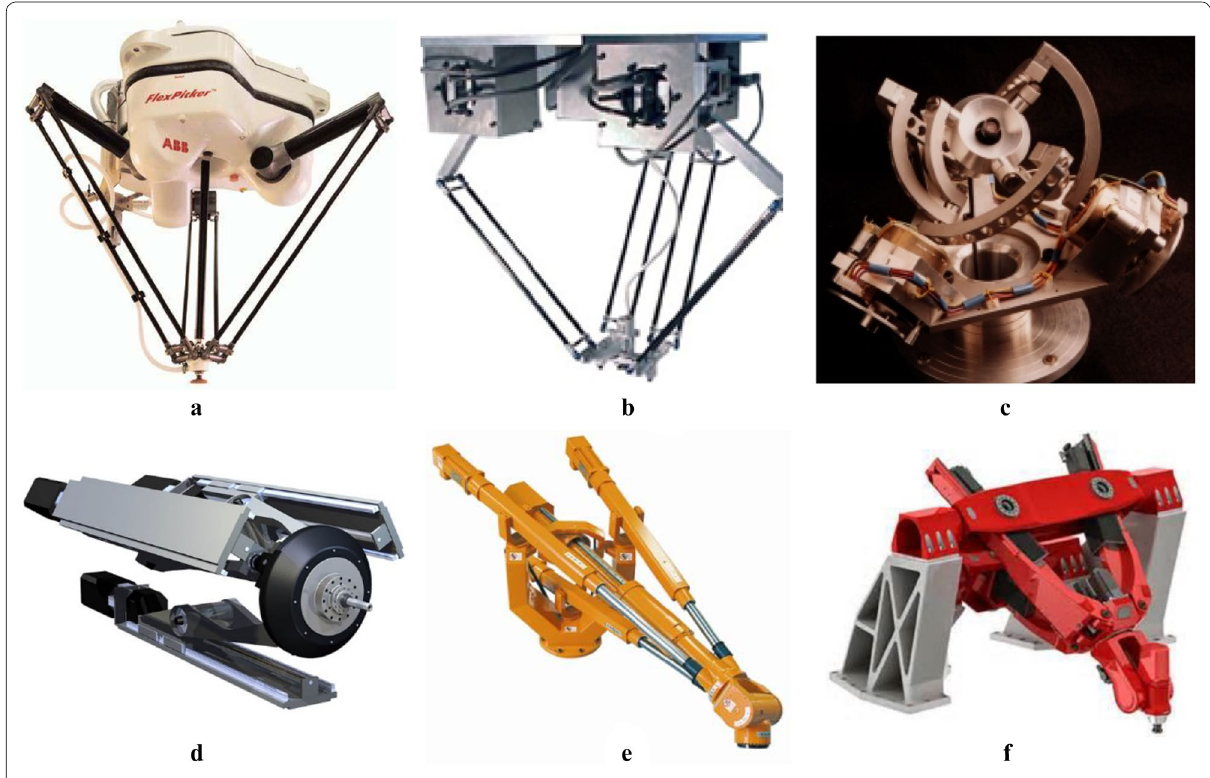
Figure 1 Typical lower mobility PMs: a the Delta robot (https ://new.abb.com/produ cts/robot ics/indus trial -robot s/irb-360); b the H4 robot [13]; c the agile eye (https ://robot .gmc.ulava l.ca/en/resea rch/resea rch-thrus ts/paral lel-mecha nisms /the-agile -eye/); d the Z3 spindle head (http://www. ds-techn ologi e.de); e the Tricept robot (http://www.pkmtr icept .com/); and f the Exechon robot (http://uniso nltd.com/innov ation /exech